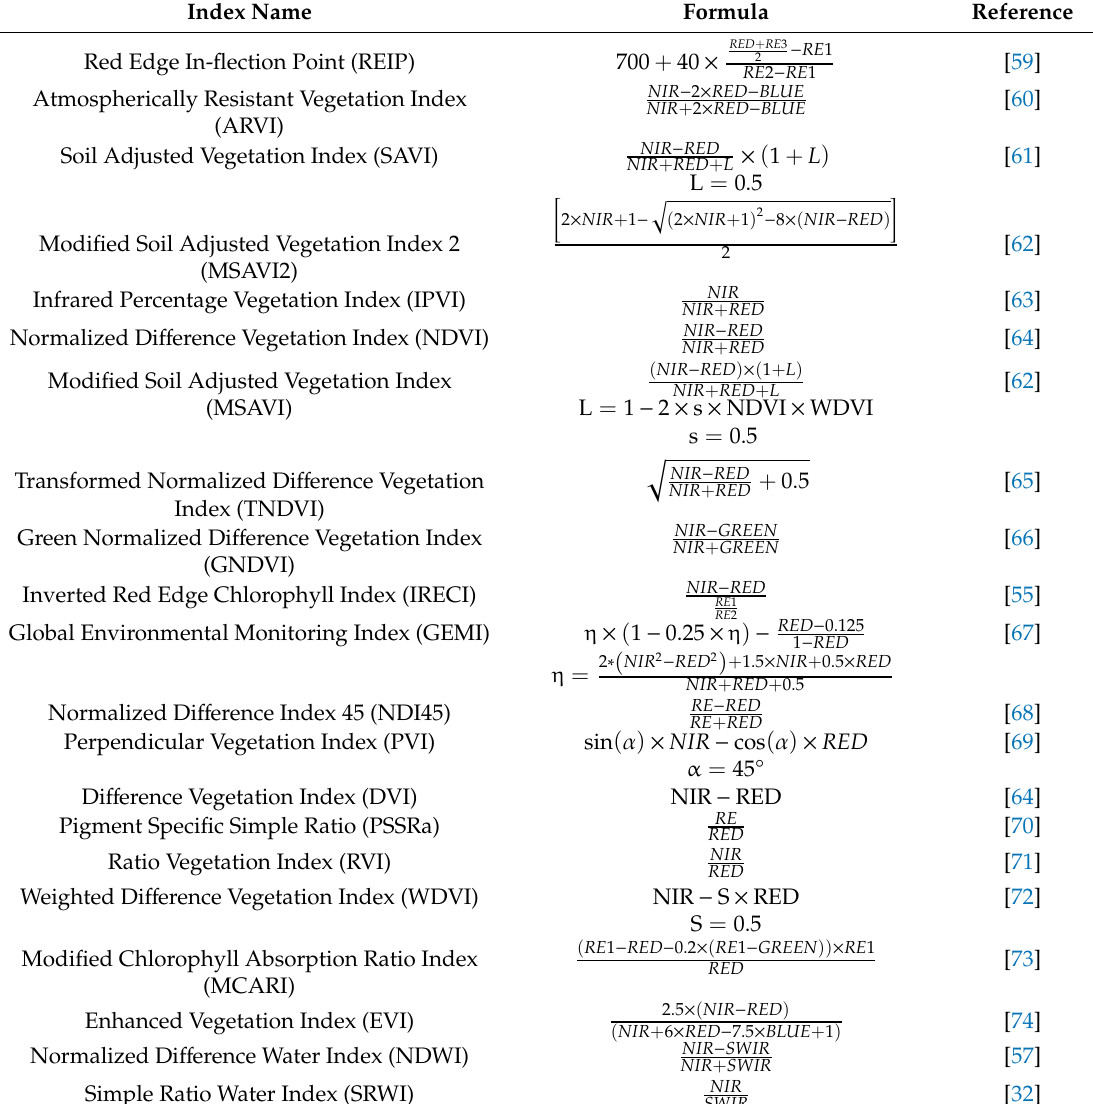
Table 2. Spectral vegetation indices that have been used to estimate stem water